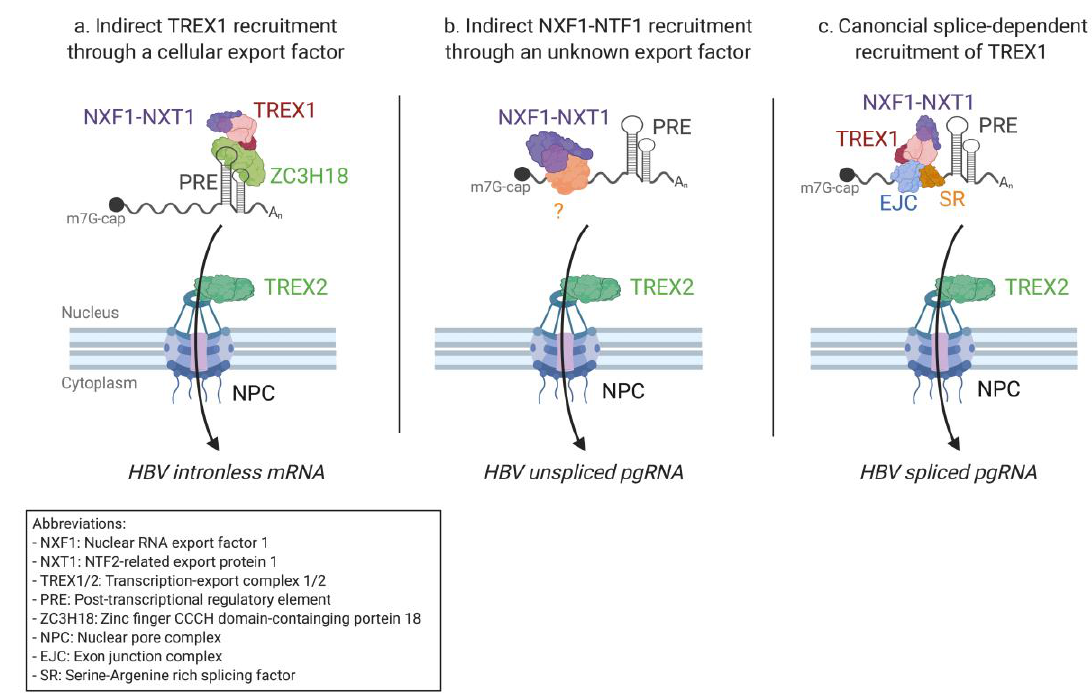
Figure 3. Hepatitis B Virus mRNA nuclear export by the NXF1–NTF1 pathway. ( a ) Hepatitis B virus intronless subgenomic mRNAs are exported through the association of the TREX1 complex to the PRE element via the cellular adapting protein ZC3H18. As is the case for the canonical mRNA export pathway, TREX1 recruits NXF1–NXT1 nuclear transport receptors allowing export through the NPC after interaction with the TREX2 complex. ( b ) Unspliced pgRNA is exported through the recruitment of NXF1–NXT1 in a PRE- and Core-independent manner. ( c ) Spliced Hepatitis B virus (HBV) pgRNAs are exported in a splicing-dependent manner, most likely through the canonical cellular mRNA export pathway.